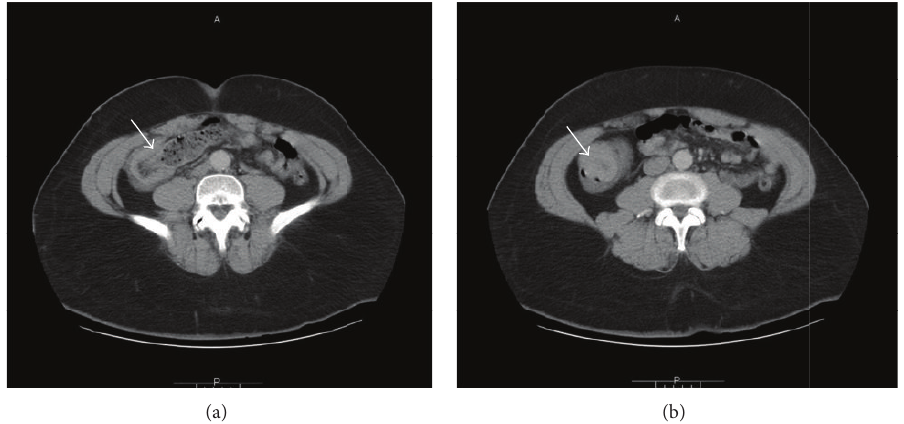
Figure 2: A computed tomography (CT) scan of the abdomen. (a) Axial CT scan at level of iliac crests shows a longitudinal sectional image of theintussusception.Aportionoftheterminalileumisinsidethececumandfarfromtheinvaginatedilealmesenterythatseparatesthewallsof the two bowel segments (arrow). (b) Cross-sectional image of the midportion of intussusception (arrow) illustrates small bowel